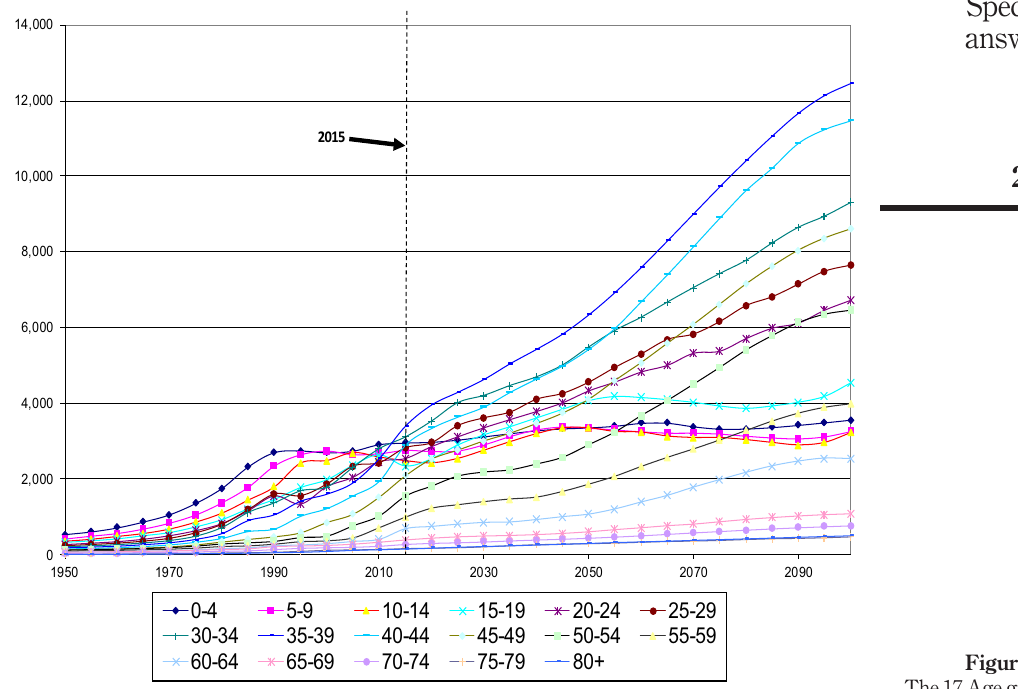
Figure 12. The 17 Age groups constituting the Saudi pyramid of ages for the 1950-2100